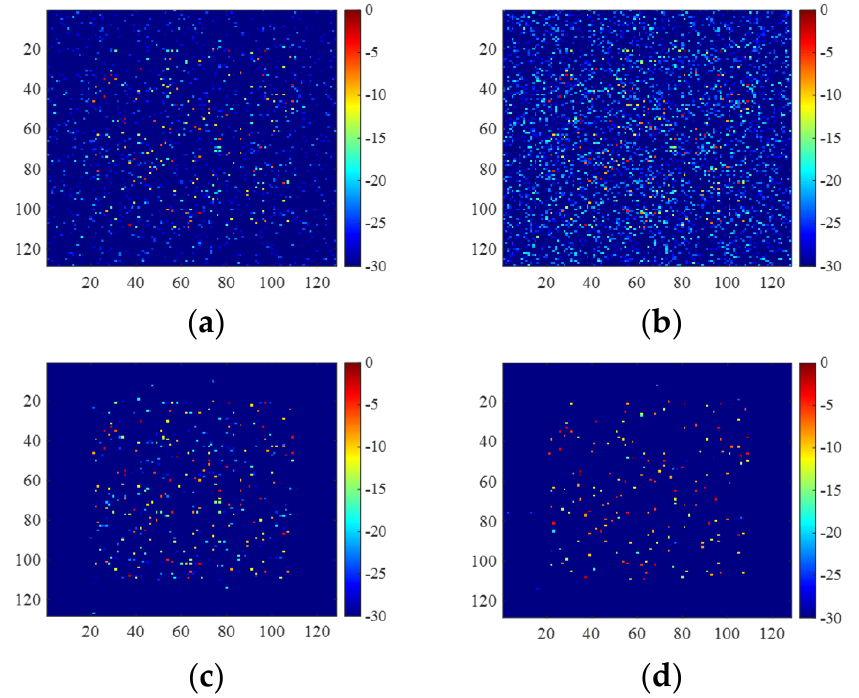
Figure 13. Images of the incomplete azimuth data with data missing pattern shown in Figure 8d, which are obtained by ( a ) 2D-FISTA, ( b ) untrained 2D-ADN, ( c ) UNet, and ( d ) trained 2D-ADN.